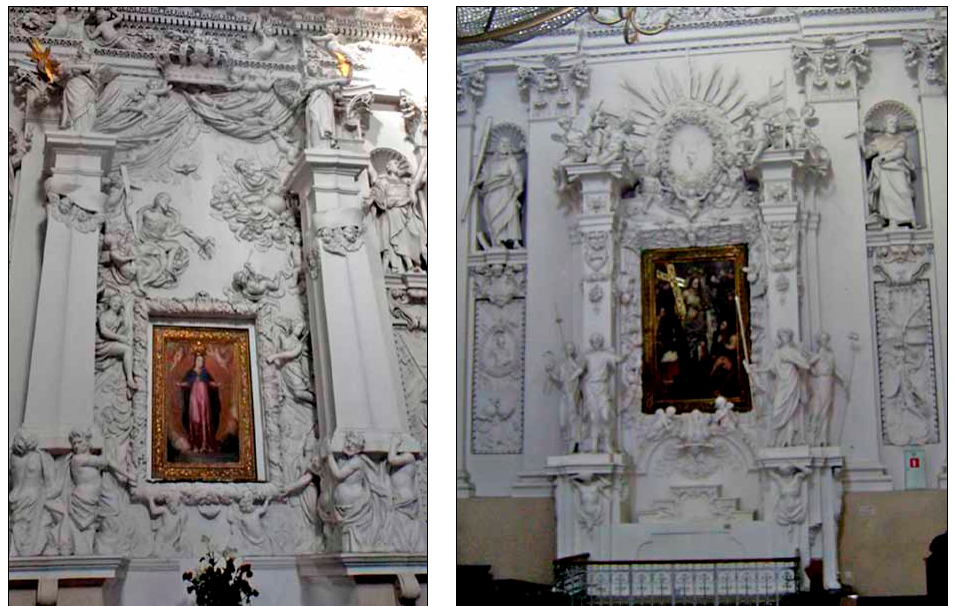
fig. 9. The two side altars of St. Peter and St. Paul’s Church devoted to our lady of Graces and five Wounds of